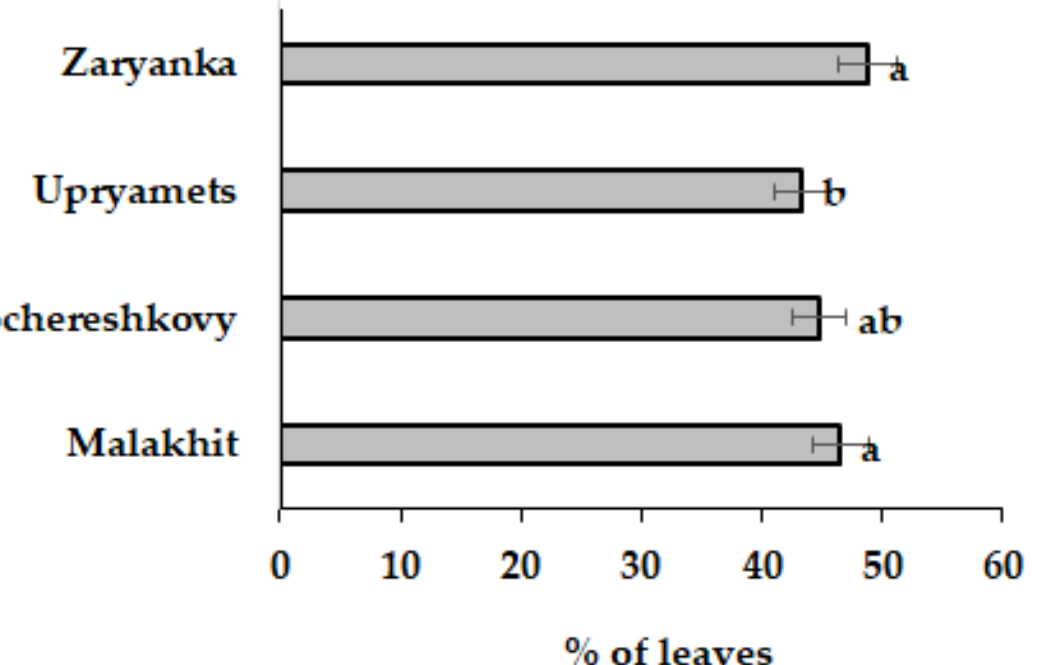
Figure 1. The leaves percentage in four rhubarb cultivars. Values with the same letters did not differ statistically according to Duncan test at p < 0.05.